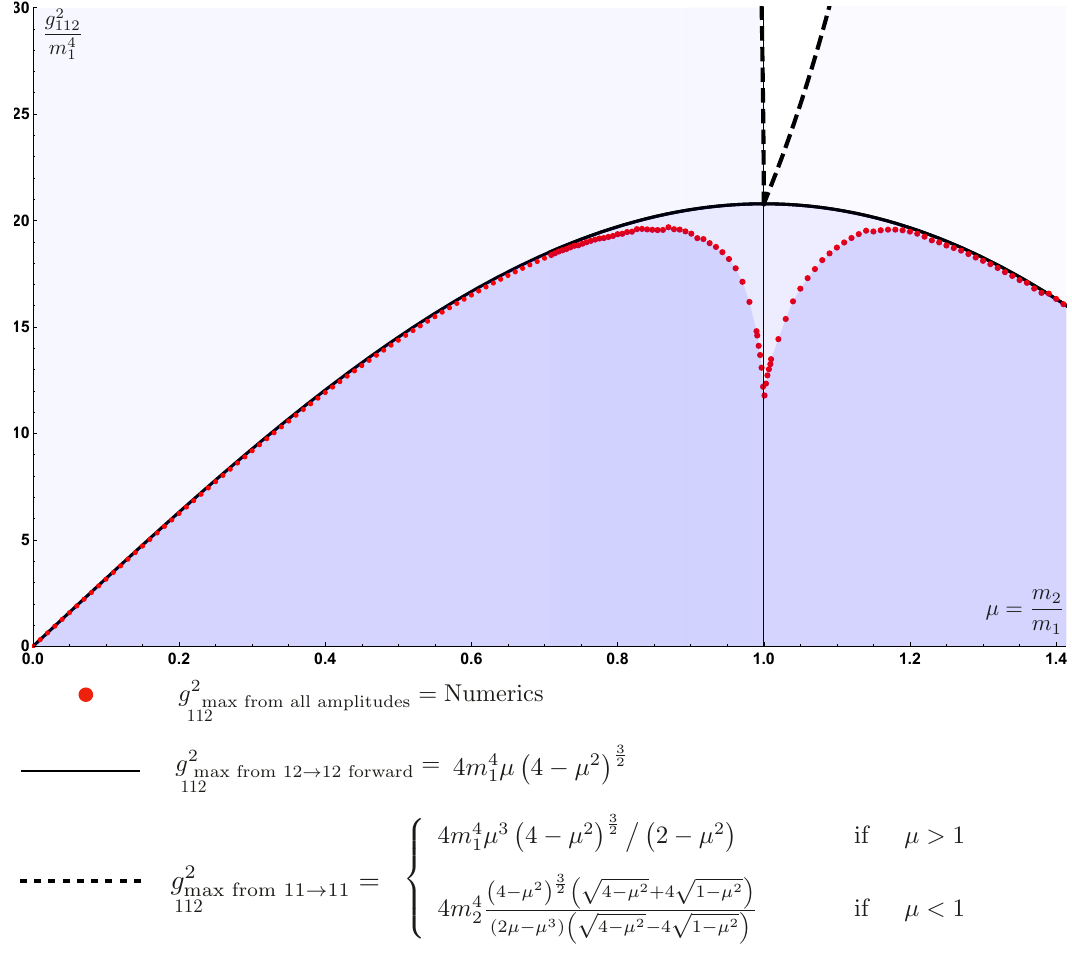
Figure 2. Upper bounds on the cubic coupling g 2 as a function of (cid:22) m 2 =m 1 . Dashed line: 112 (cid:17) analytic bound based on the scattering of the lightest odd particle, from [2]. Solid line: analytic bound arising from the forward (or transmission) scattering of the odd particle against the even particle; it is a much stronger bound. Red dots: the numeric bound obtained from all two-to-two processes as discussed in the main text. The shaded regions represent the allowed regions which nicely shrink as we include more constraints. Any relativistic, unitary, Z 2 invariant theory theory with two stable particles (one odd with mass m 1 and one even with mass m 2 ) must lie inside the darkest blue